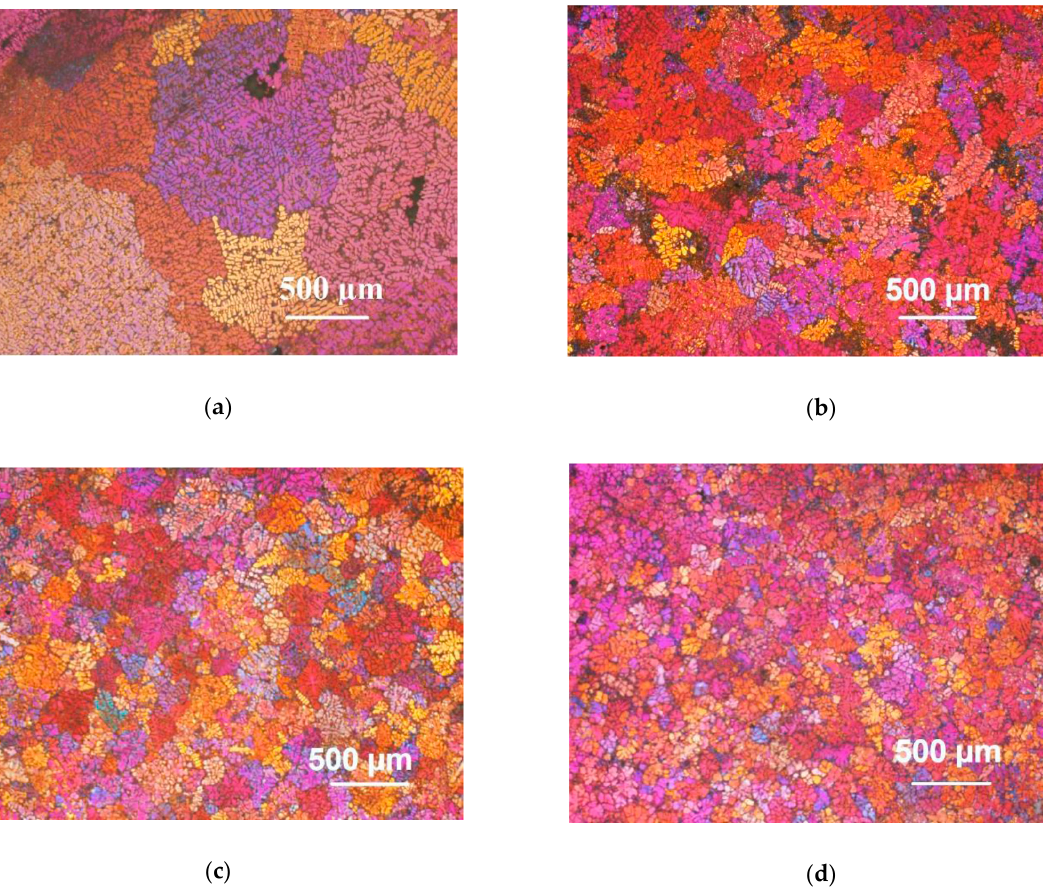
Figure 3. Microstructure of A356 alloy without treatment ( a ), A356 after ultrasonic treatment ( b ), A356–0.2% ScF 3 ( c ), and A356–1% ScF 3 ( d ).